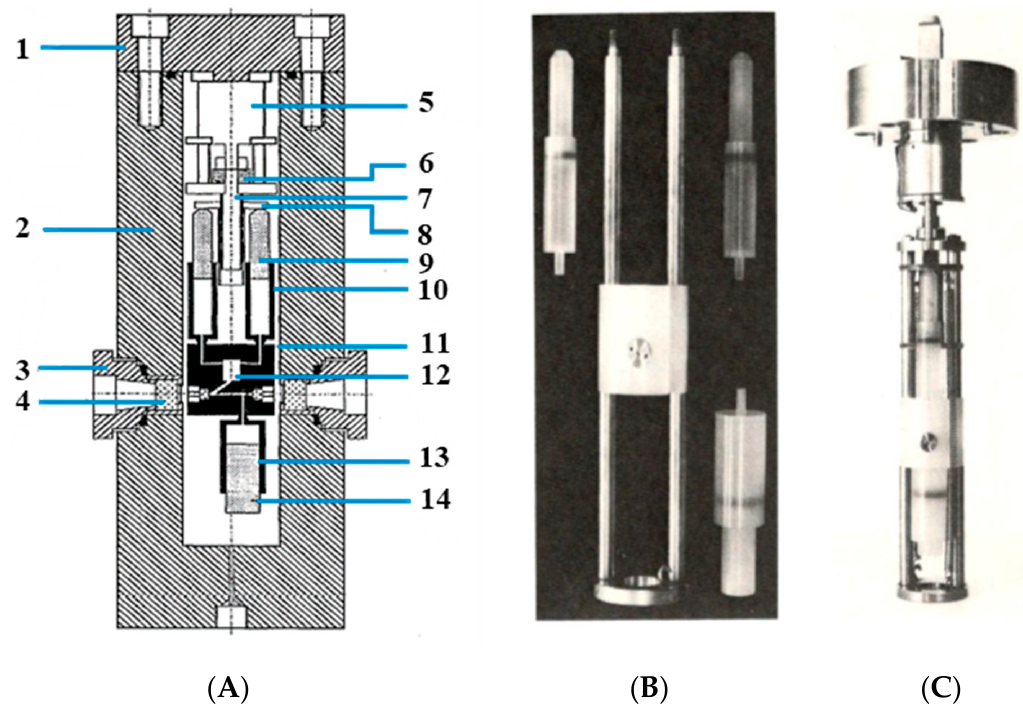
Figure 3. ( A ) Cross-sectional diagram of the high-pressure vessel and stopped-flow apparatus. (1) Pressure vessel lid, (2) pressure vessel, (3) high-pressure window seal assembly, (4) high-pressure sapphire window, (5) step motor, (6) screw-drive mechanism, (7) drive shaft, (8) syringe thrust plate, (9) reactant syringe pistons, (10) reactant syringes, (11) Kel-F cell block, (12) mixing jet, (13) receiver syringe, and (14) receiver-syringe piston. ( B ) High-pressure stopped-flow instrument as constructed by van Eldik and co-workers [21]. Essential components, such as syringes and mixing chamber. ( C ) Complete unit attached to the lid of the pressure cell. Reproduced from Reference [21], with the permission of AIP Publishing.